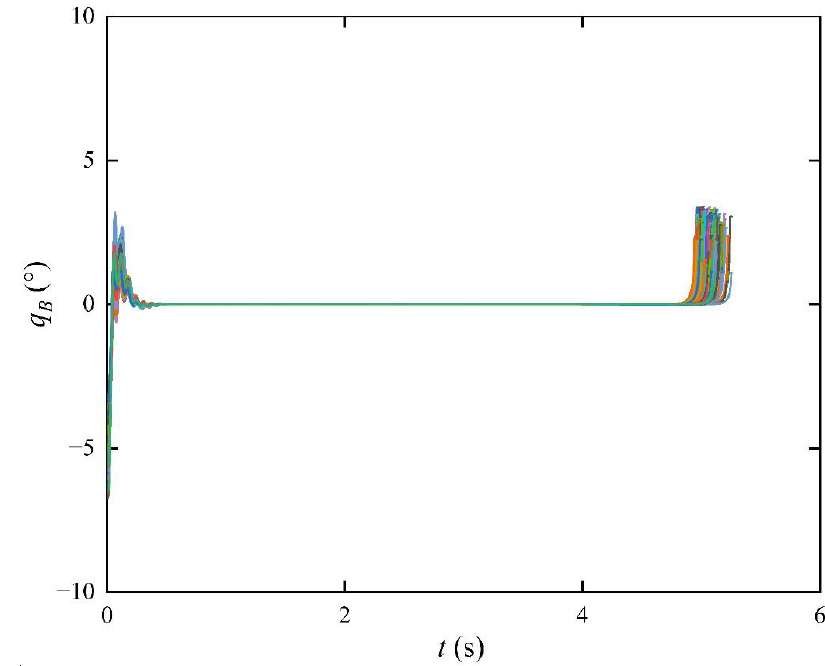
Figure 5. BLOS angles of Monte Carlo simulation under Case 3.